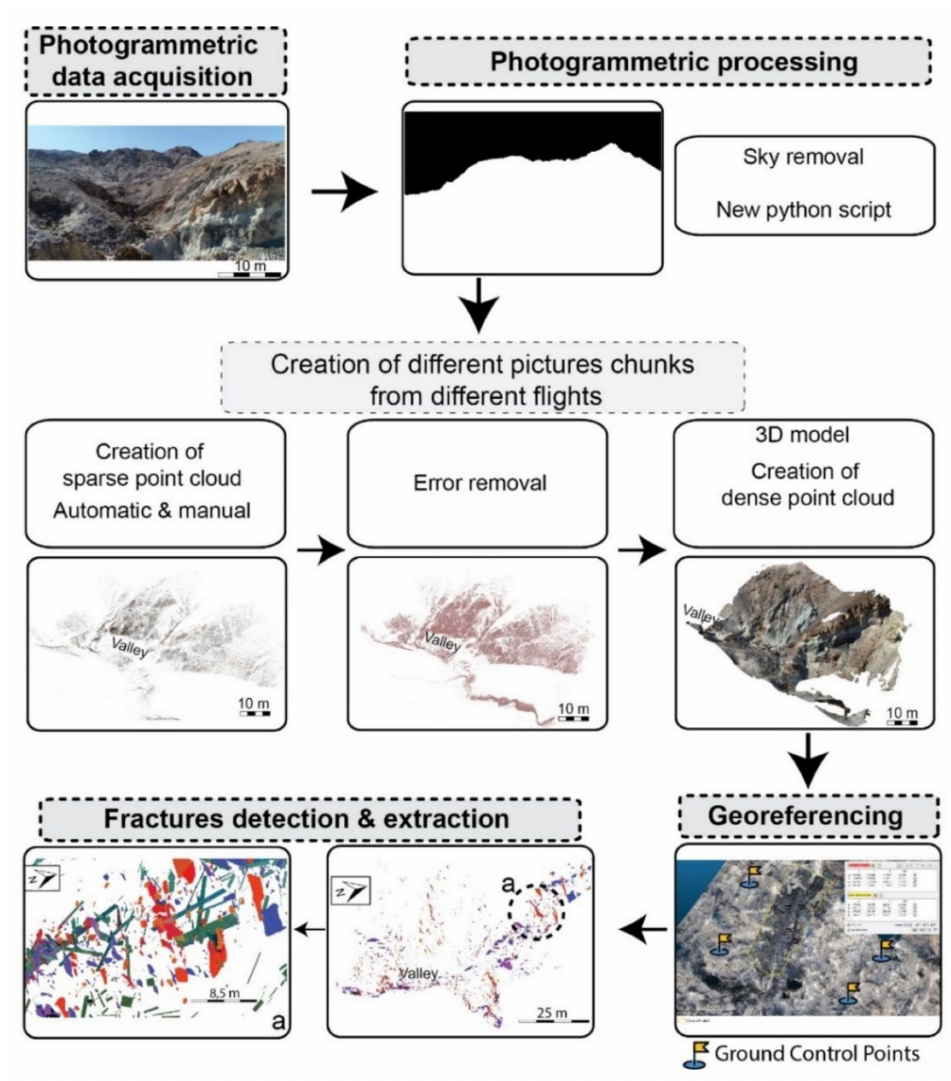
Figure 3. Workflow illustrating the different steps to build the 3D photogrammetric models, georef- erencing, and fractures detection and extraction. Modified after Chabani et al.